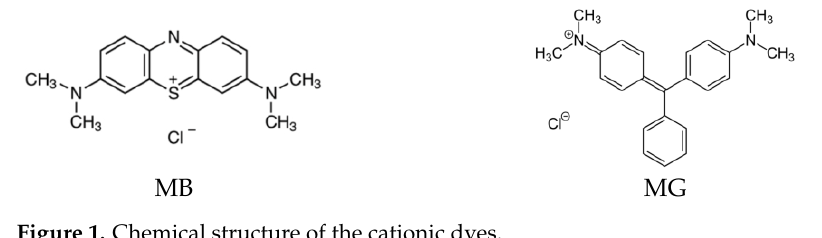
Figure 1. Chemical structure of the cationic dyes.